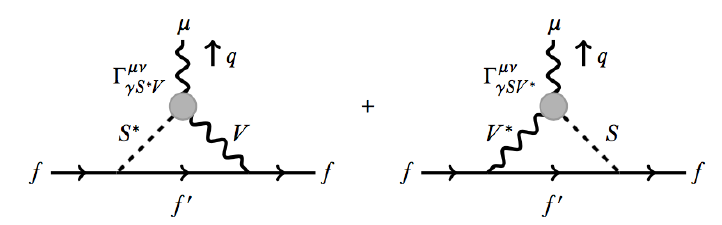
Figure 3 . Computation of the outer loop in the general case that S , V are complex (cid:12)elds.